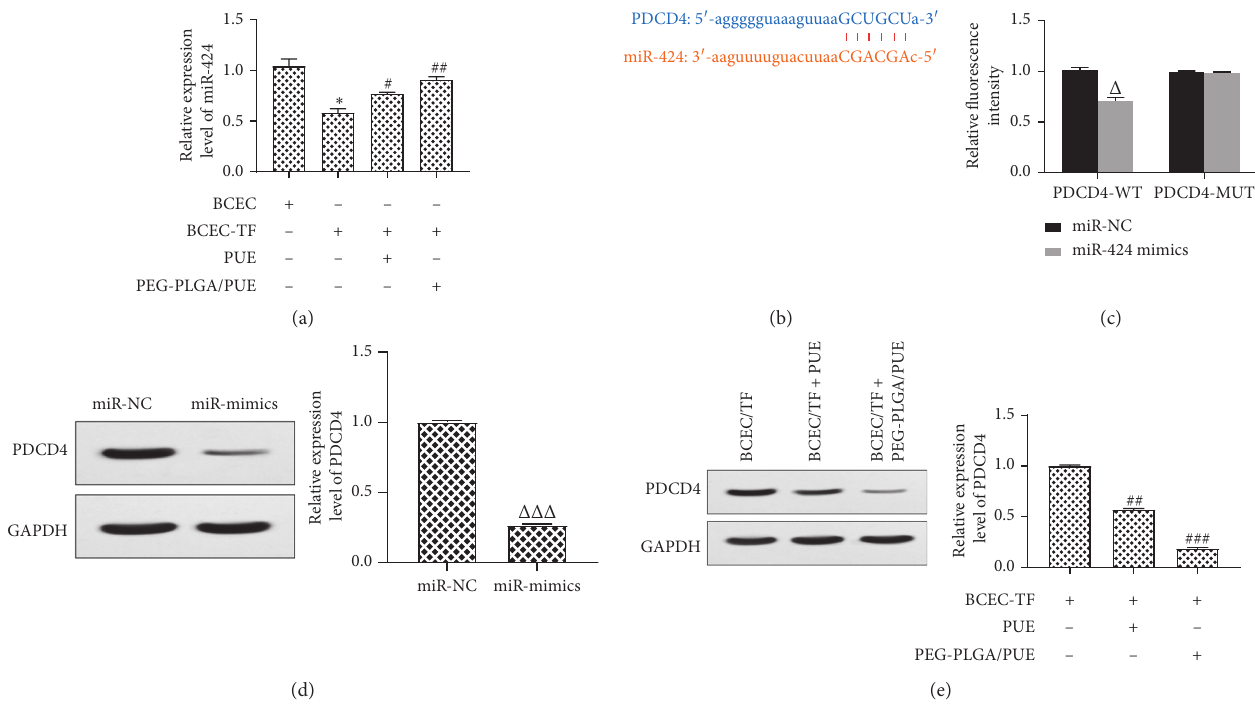
Figure 4: Mechanism of action of PEG-PLGA/PUE on BCEC/TF cells. (a) Relative expression of miR-424 on cells. (b) Gene sequence binding site. (c) Relative fluorescence intensity. (d, e) Protein expression level (data are shown by mean ± SD, N � 3; ∗ P < 0 . 05 vs. BCEC group; # P < 0 . 05, ## P < 0 . 01, and ### P < 0 . 001 vs. BCEC/TF group; Δ P < 0 . 05 and ΔΔΔ P < 0 . 001 vs. miR-NC